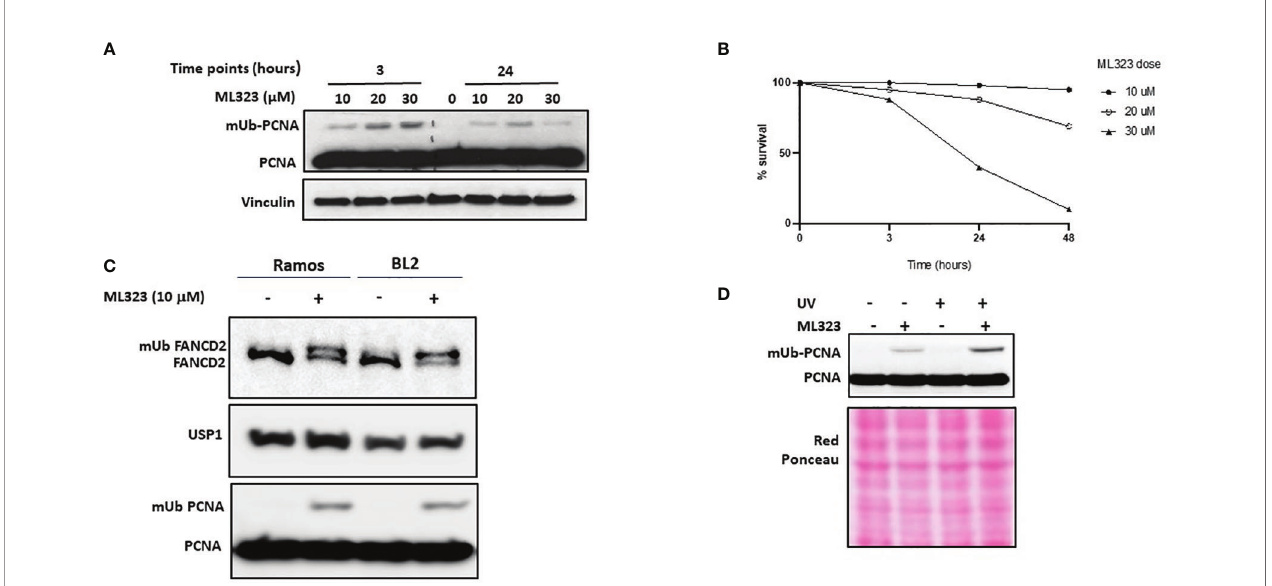
FIGURE 2 | Inhibition of USP1 increases the monoubiquitination of both PCNA and FANCD2. Ramos cells were incubated with increased doses of ML323, and the monoubiquitination of PCNA and the cell toxicity of the drug at the indicated times were determined by SDS – PAGE and immunoblotting in (A) and using a cell survival assay in (B) , respectively. The data in B represent the mean of three independent experiments. (C) Ramos and BL2 cells were treated for two hours with 10 m M ML323, and monoubiquitination of PCNA and FANCD2 was analyzed by SDS – PAGE and immunoblotting. (D) Ramos cells were treated with UVC, ML323 or both, and the monoubiquitination of PCNA was analyzed as described above. Vinculin and red Ponceau were used as loading